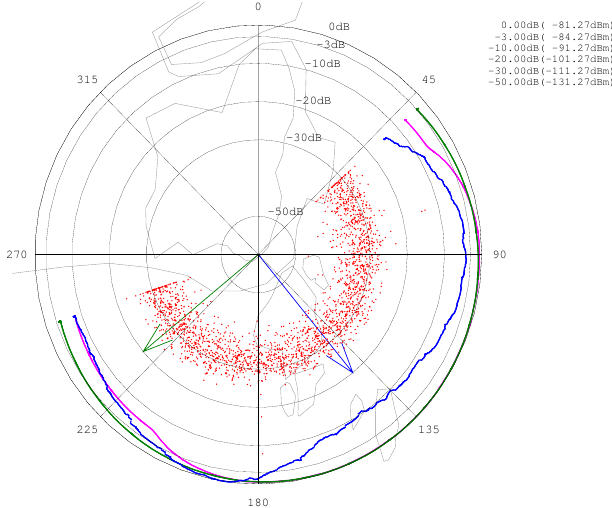
Figure 13. Results of the APM performed on the TWLA deployed at Seal Rocks site on 30 January 2020. Here, data are displayed relative to a single drone passages in a clockwise direction. See (Figure 10) for colour